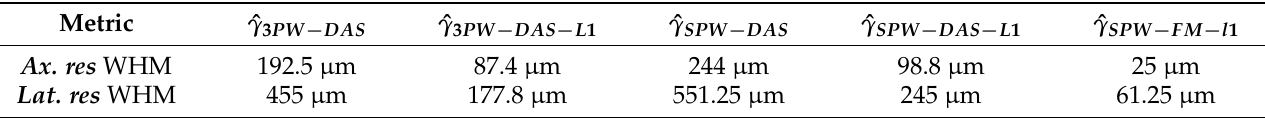
Table 1. Image quality metrics evaluated on the simulated wire phantom.